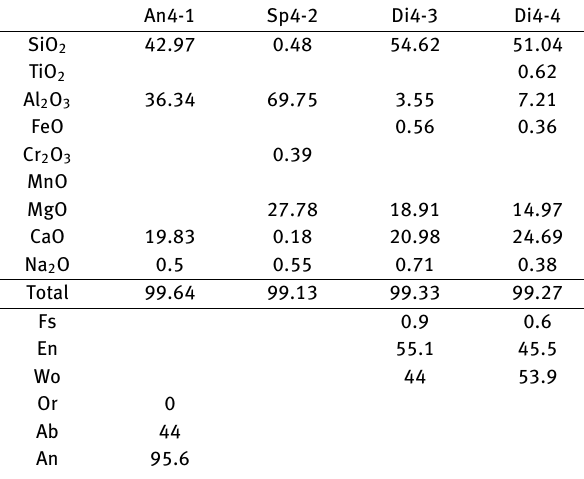
Table 1. Chemical composition of anorthite (An), spinel (sp) and diopside (Di) in Kaba meteorite (Gucsik et al.